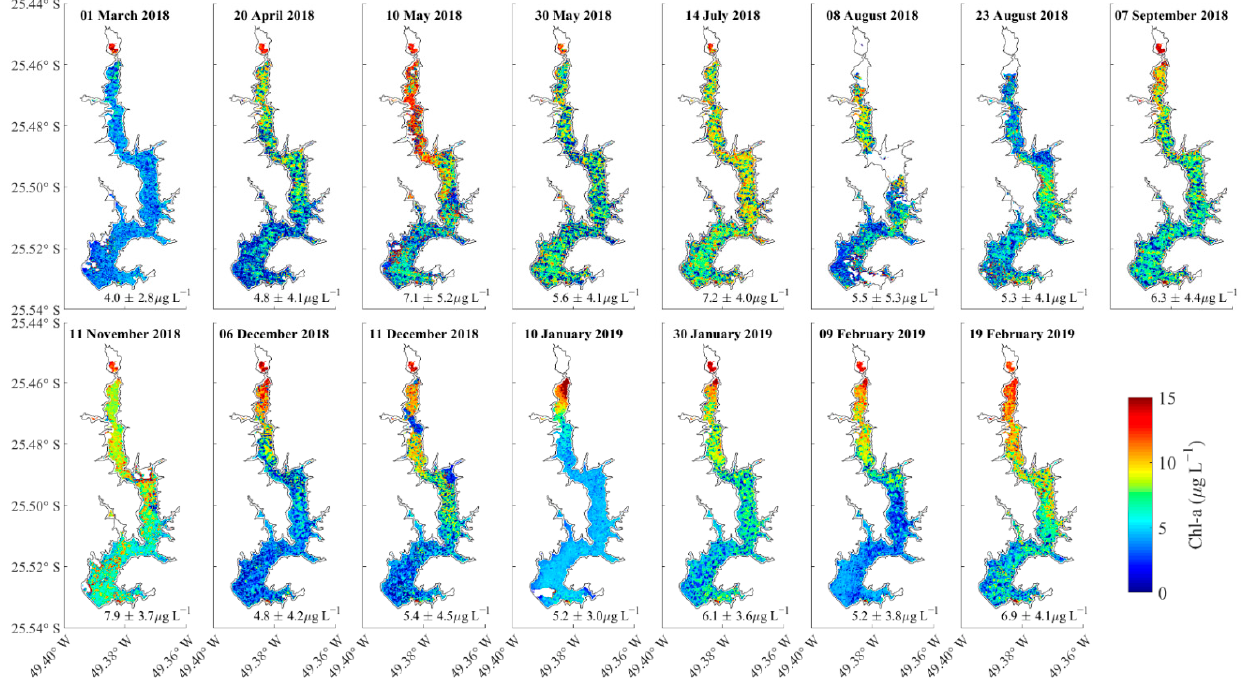
Figure 6. Maps of remote sensing estimates of chla concentrations for the days indicated in the title of each panel. The mean (±standard deviation) concentration is presented as a text label below each map.